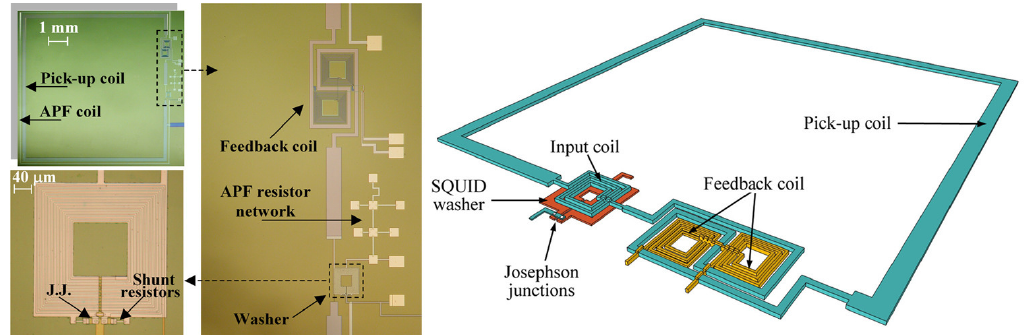
Figure 1. A picture of a superconducting quantum inference device (SQUID) sensor with additional positive feedback and a feedback coil. On the right, a sketch of the SQUID magnetometer showing the main circuit elements is reported.